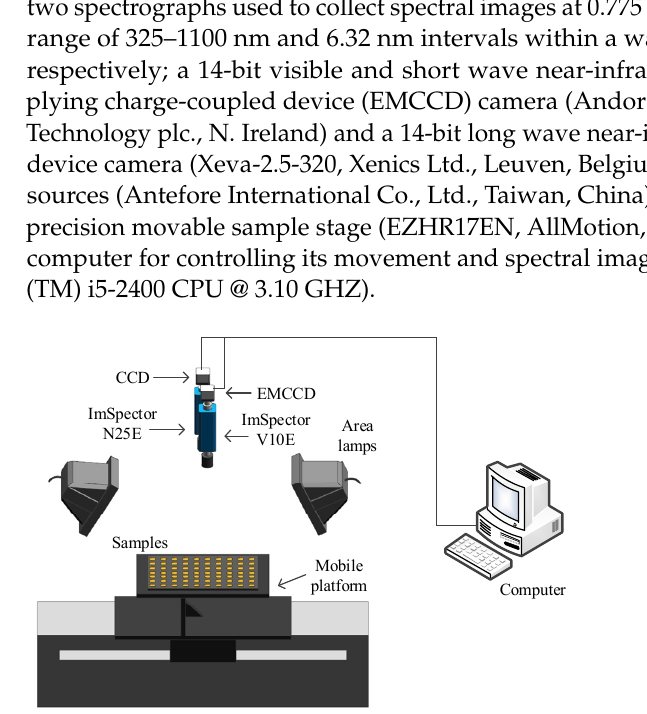
Figure 1. Hyperspectral image acquisition system.